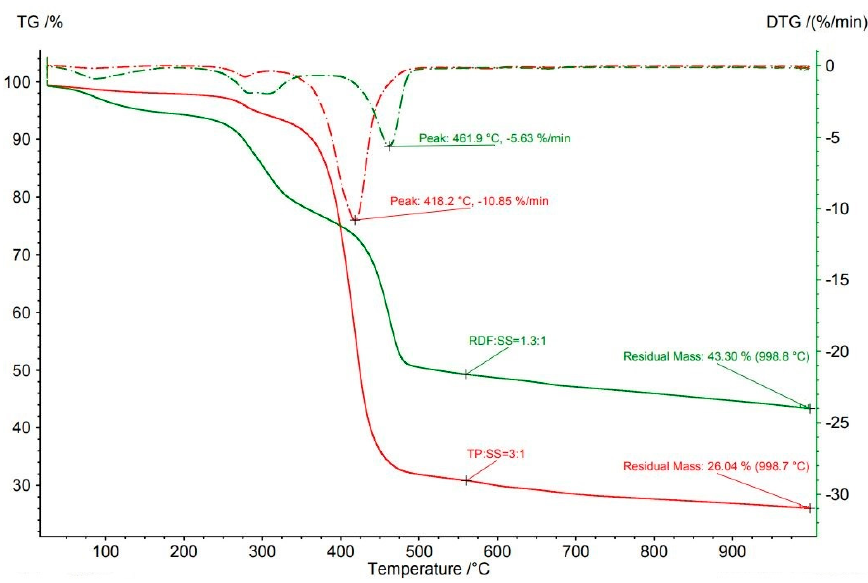
Figure 10. TG/DTG curves of RDF:SS and TP:SS in 2 different volume ratios.